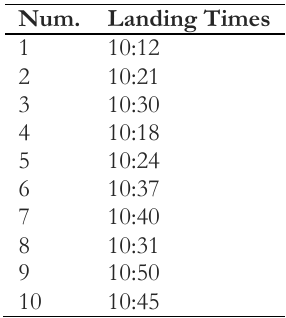
Table 1. Expected landing times for 10